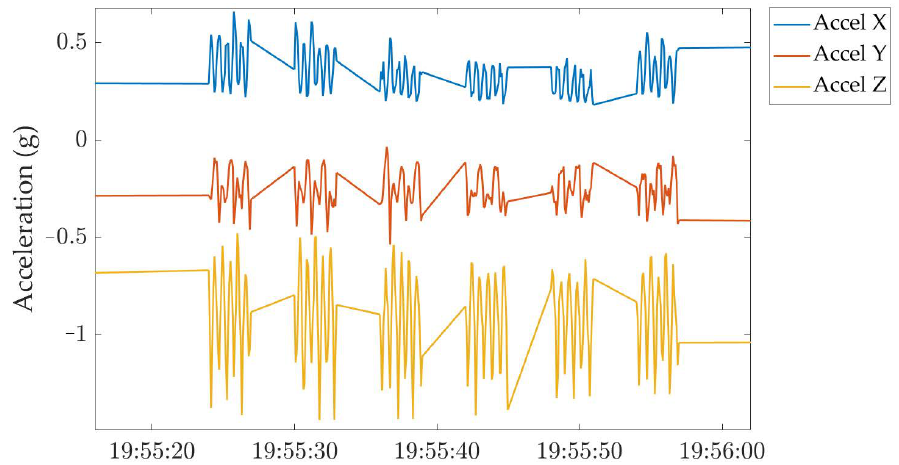
Figure 13. Burst movement streaming using LoRaWAN (DR5) in mountains (12 km range).